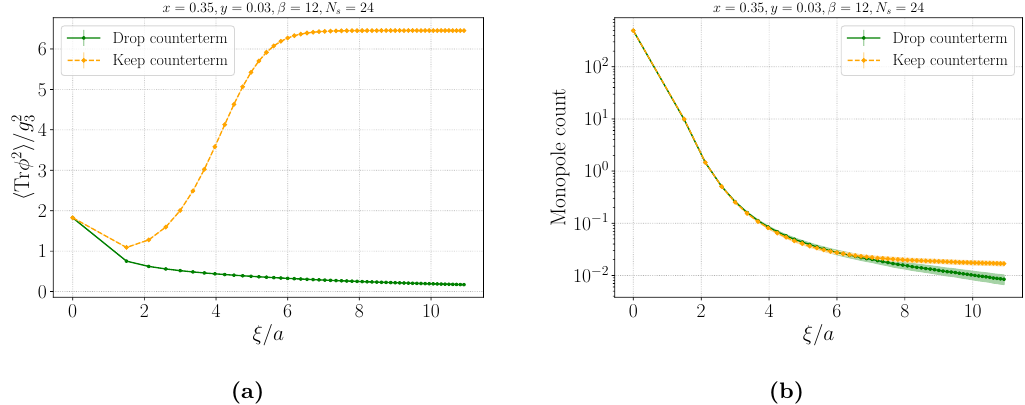
Figure 2 . Comparison of two the gradient flow schemes described in the text. (a) Higgs condensate, (b) average number of magnetic monopoles in the system. The bare mass m 2 flow equations is larger (smaller) for solid (dashed) lines due to the presence or absence of a UV counterterm. Data points are shown for clarity; the spacing is nonuniform due to the nonlinear relation between ξ and the flow time τ